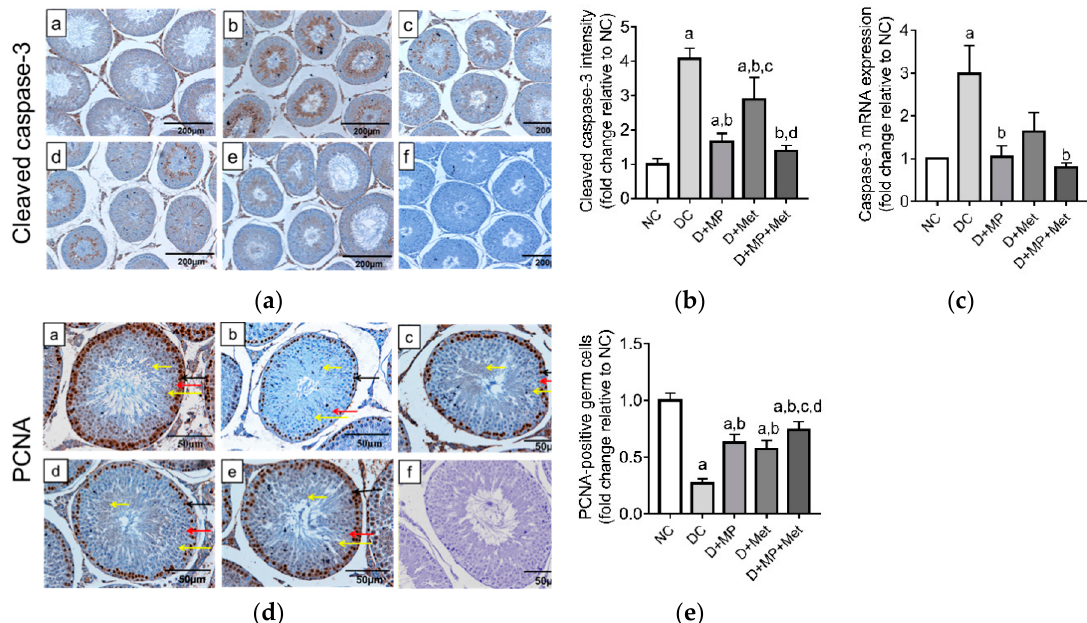
Figure 8. Expression of Caspase ‐ 3 protein ( a , b ) and mRNA levels ( c ), and proliferating cell nuclear antigen immunostaining ( d , e ) in the testes of ( a ) NC, ( b ) DC, ( c ) D+MP, ( d ) D+Met and ( e ) D+MP+Met groups. Representative photomicrograph of the negative control is shown as ( f ) (magnification = ×100, scale bar = 200 μ m). For quantitative data, values are expressed as mean ± SD, n = 8 (for staining intensity) and n = 6 (for mRNA expression). a p < 0.05 versus NC, b p < 0.05 versus DC, c p < 0.05 versus D+MP, d p < 0.05 versus D+Met (one ‐ way ANOVA followed by Tukey’s post ‐ hoc test). NC: normoglycaemic control, DC: diabetic control, D+MP: diabetic rats treated with Malaysian propolis, D+Met: diabetic rats treated with metformin, D+MP+Met: diabetic rats treated with Malaysian propolis + metformin.